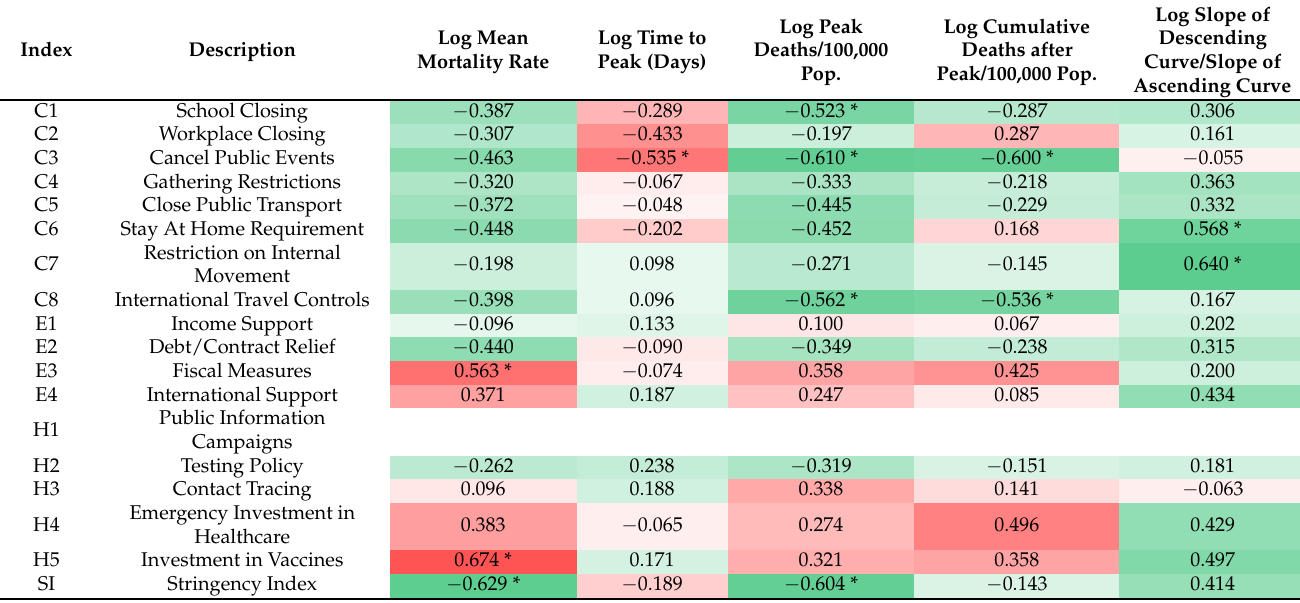
Table 6. Spearman rank-order correlation coefficient of policy indicators and the Stringency Index against five different measures of pandemic severity in European countries.